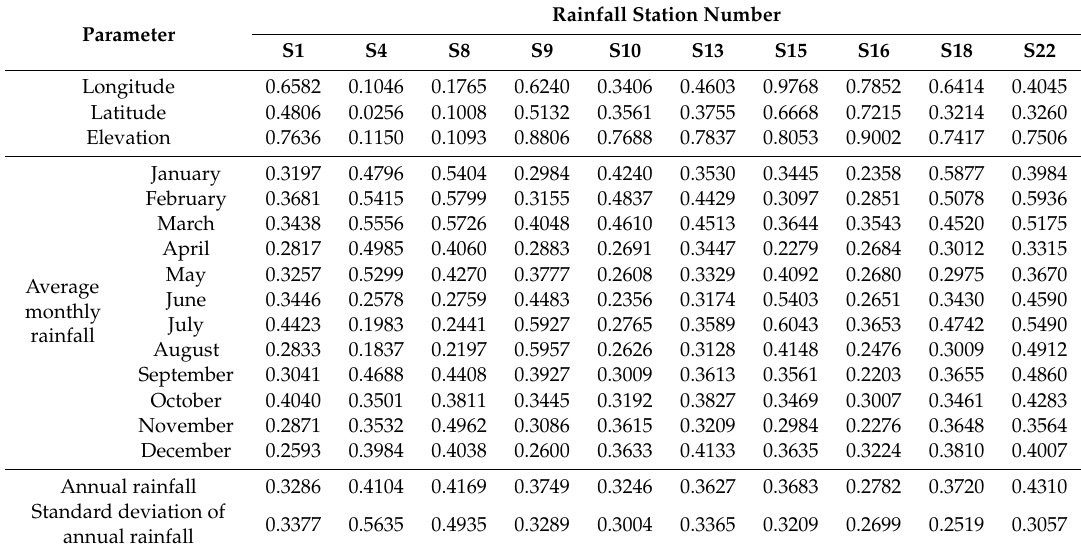
Table 4. Normalized input variables for selected first ten rainfall